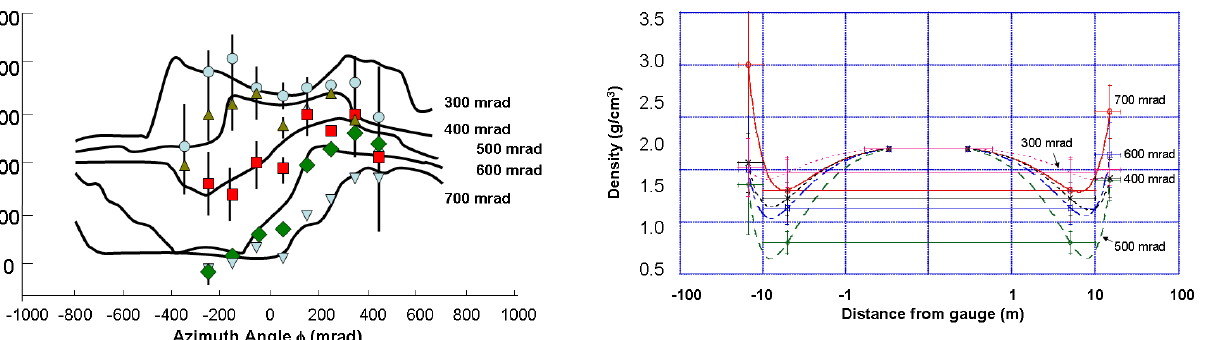
Fig. 4. Elevation dependence of the density length as a function of azimuth angle. The solid lines show the density lengths as mea- sured from the topographic map by assuming a uniform density of 2.0gcm − 3 . The measurements and the related error bars can be referred to the scale and unit on the vertical axis. The bottom axes indicate the azimuth angles ( ϕ in units of mrad) with refer- ence to the line perpendicular to the detector plane and path lengths respectively.